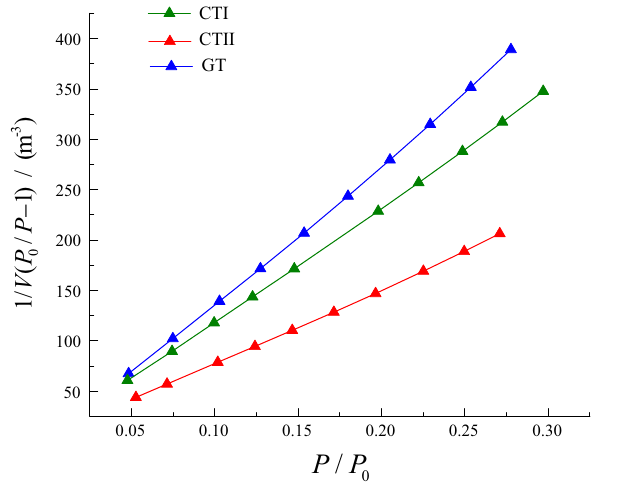
Figure 14. The BET curves of